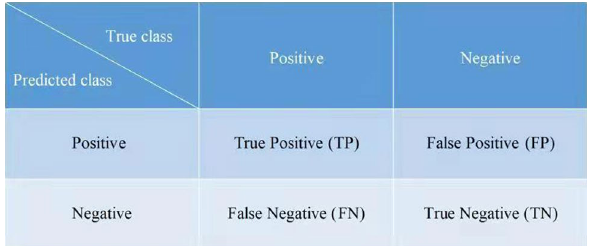
Fig. 2 The confusion matrix